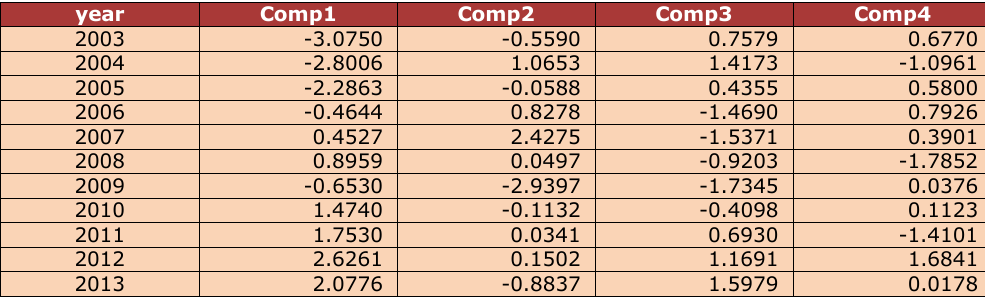
Table 5. First Four Principal Component Factor Score